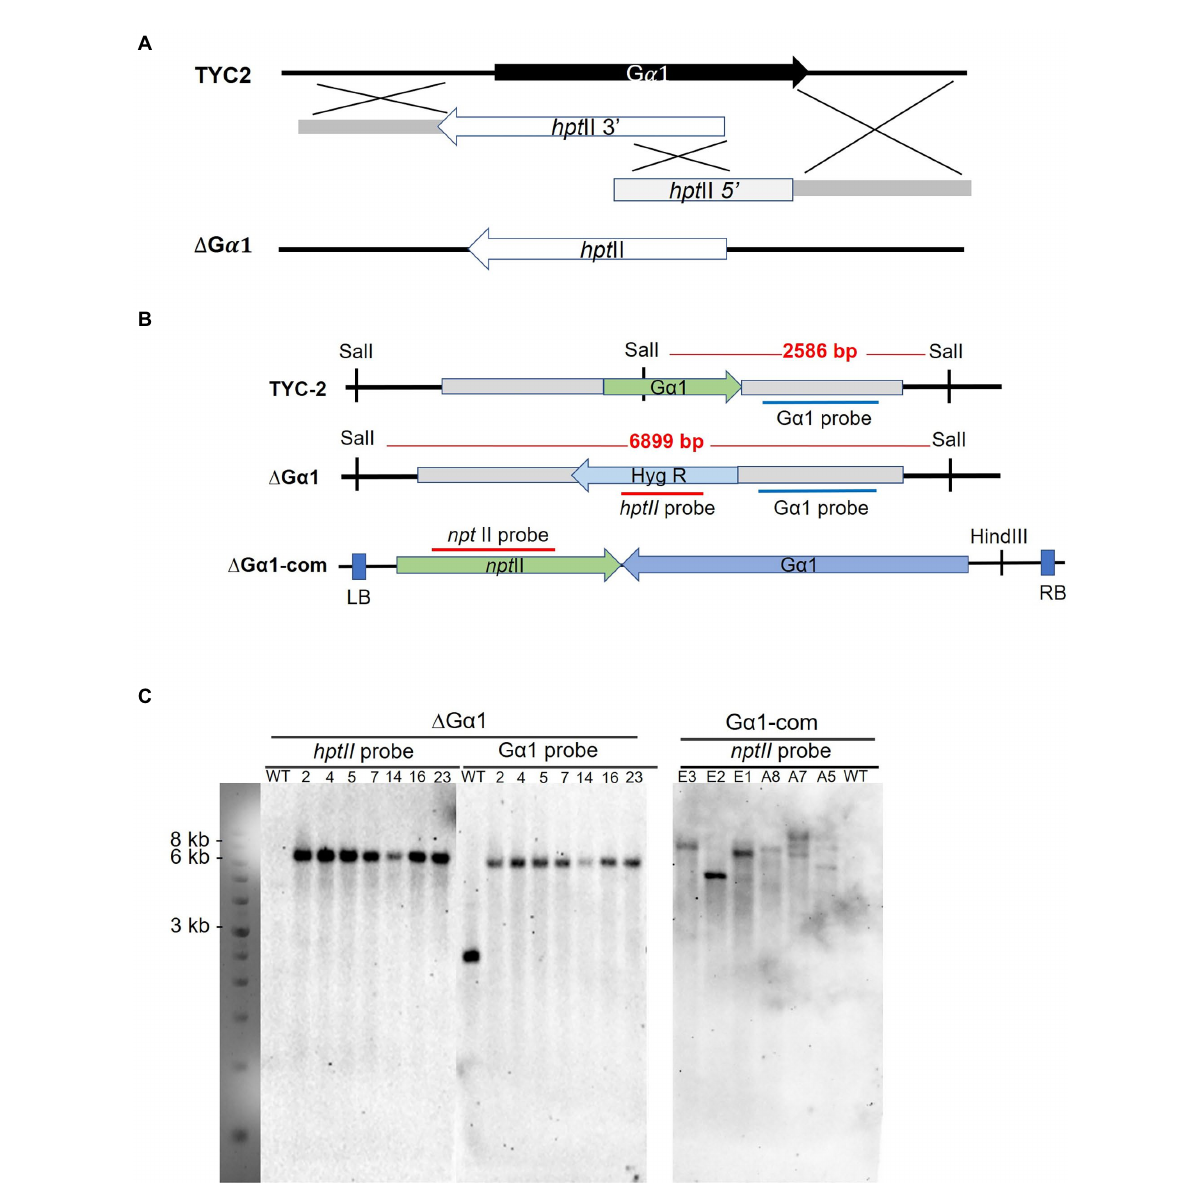
FIGURE 4 Gene disruption with a split-marker strategy via homologous recombination is illustrated (A) . The restriction map (B) and hybridization results of Southern blot analysis for the CaG 𝛼 1 gene disruption and complementation strains are presented (C)